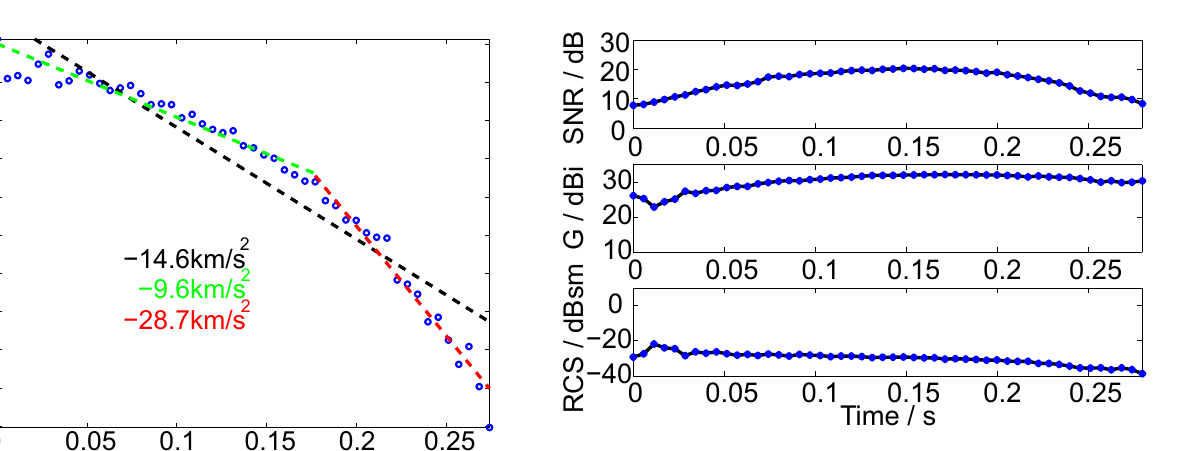
Fig. 6. Top: SNR; centre: antenna gain on the meteoroid position; bottom: RCS of the meteor-head